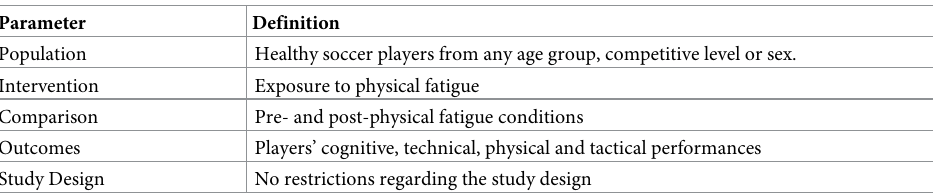
Table 1. Definition of PICOS for inclusion and exclusion of